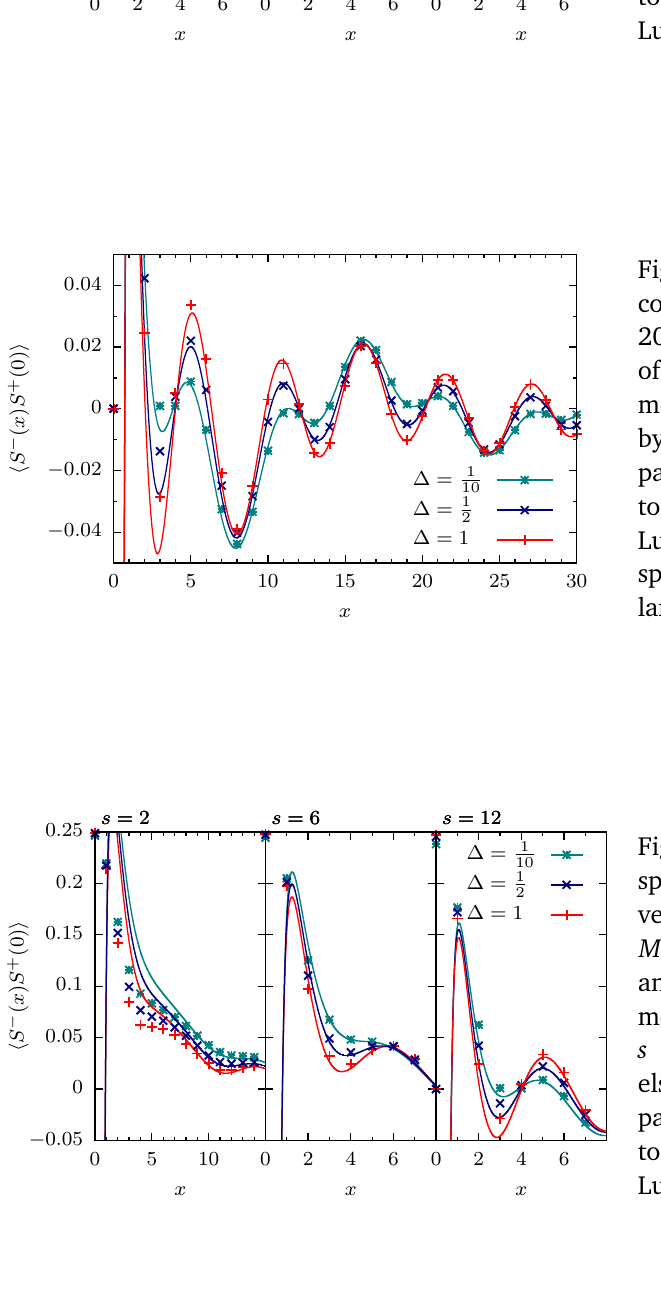
Figure 8: Longitudinal static real space correlation 〈 S z ( x ) S z ( 0 ) 〉 for very short distances, at N = 200, M = 50 for several values of the anisotropy, for states with a mo- mentum split in the Fermi sea by s = 2,6,12 (from left to right pan- els respectively). The figure com- pares the ABACUS results (points) to the multi-component Tomonaga- Luttinger model (lines).